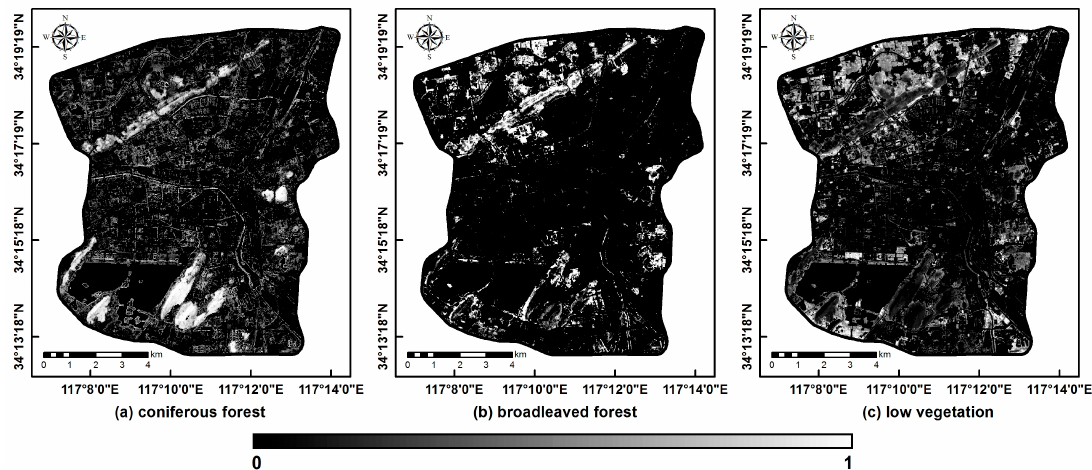
Figure 5. Vegetation abundance maps: ( a ) coniferous forest; ( b ) broadleaved forest; ( c ) low vegetation.